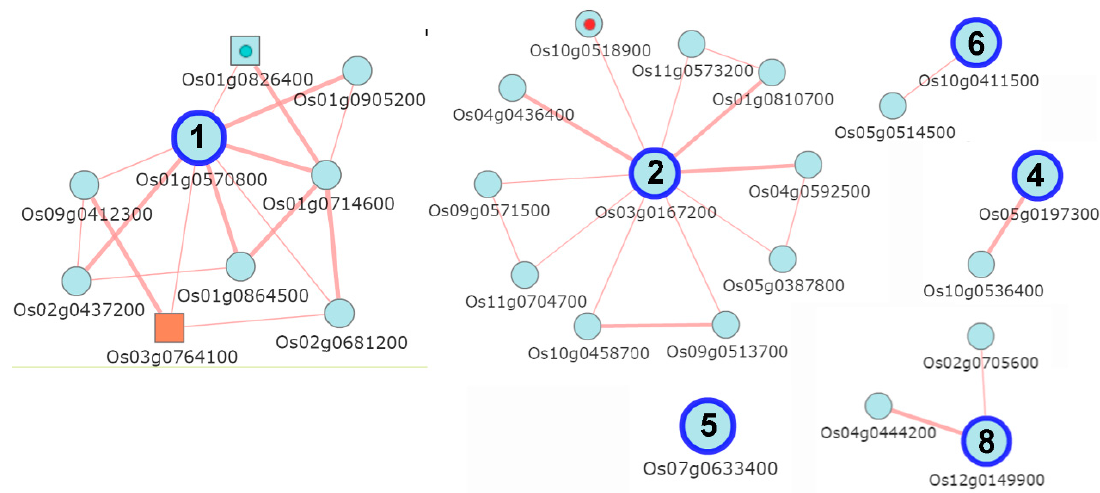
Figure 10. Co-expression network of the eight OsIQMs. The numbers represent the corresponding OsIQMs genes. The KEGG pathways are highlighted as dots: red—nucleotide excision repair (osa03420); blue—plant–pathogen interaction (osa04626).